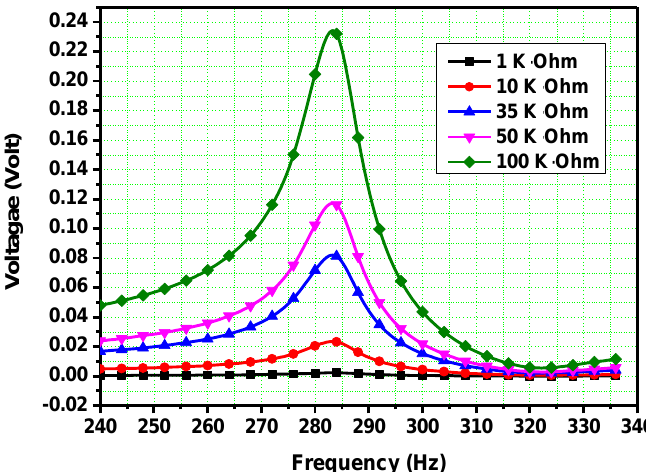
Figure 10. Effect of resistances and output voltage.